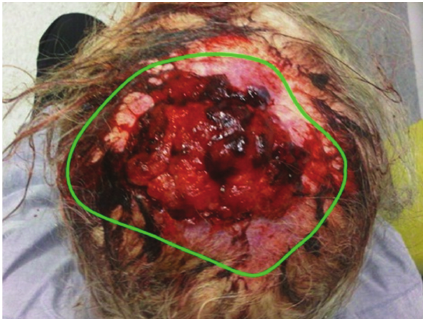
Figure 4: Patient of Case 1 is disease-free at a postoperative followup of 4 months (posterior view of the scalp). At three weeks after the completion of all radiotherapy, the tumour was treated with surgical excision and split-thickness skin